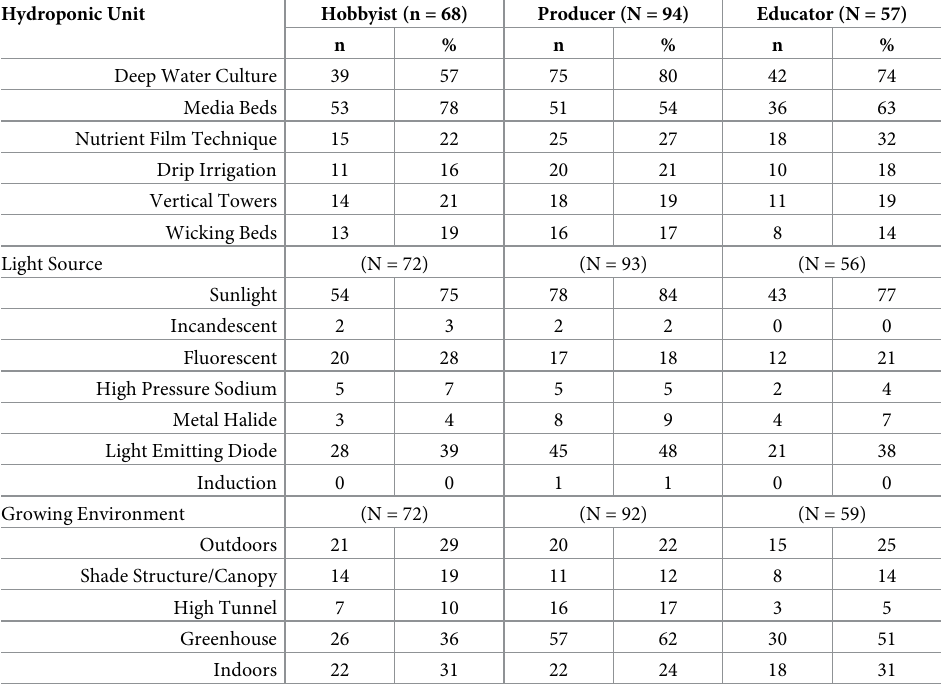
Table 2. Horticulture production system components for aquaponic hobbyists, producers, and